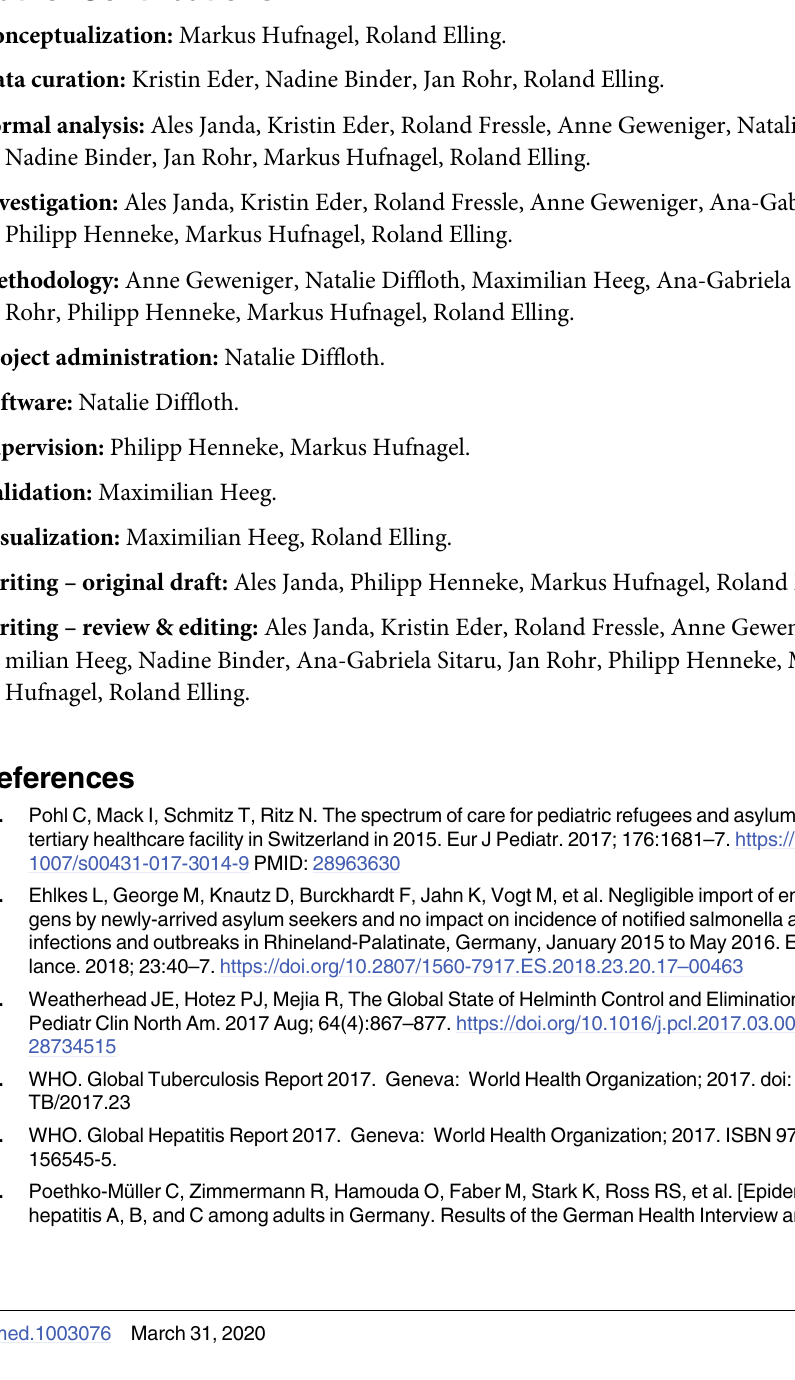
S2 Table. Clinical warning signs for active tuberculosis infection in screened unaccompa- nied refugee minors ( n =